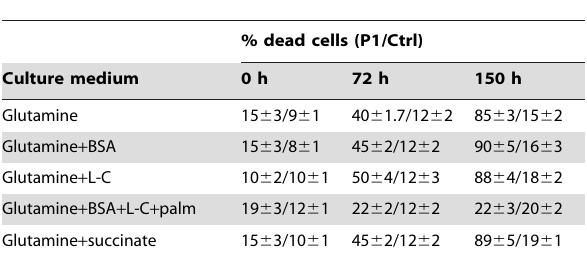
Table 2. Effect of bovine serum albumin (BSA), L-carnitine, (BSA + L-carnitine + palmitate) and succinate on glucose withdrawal-induced cell death in patient 1 (P1) and control (Ctrl) cells.